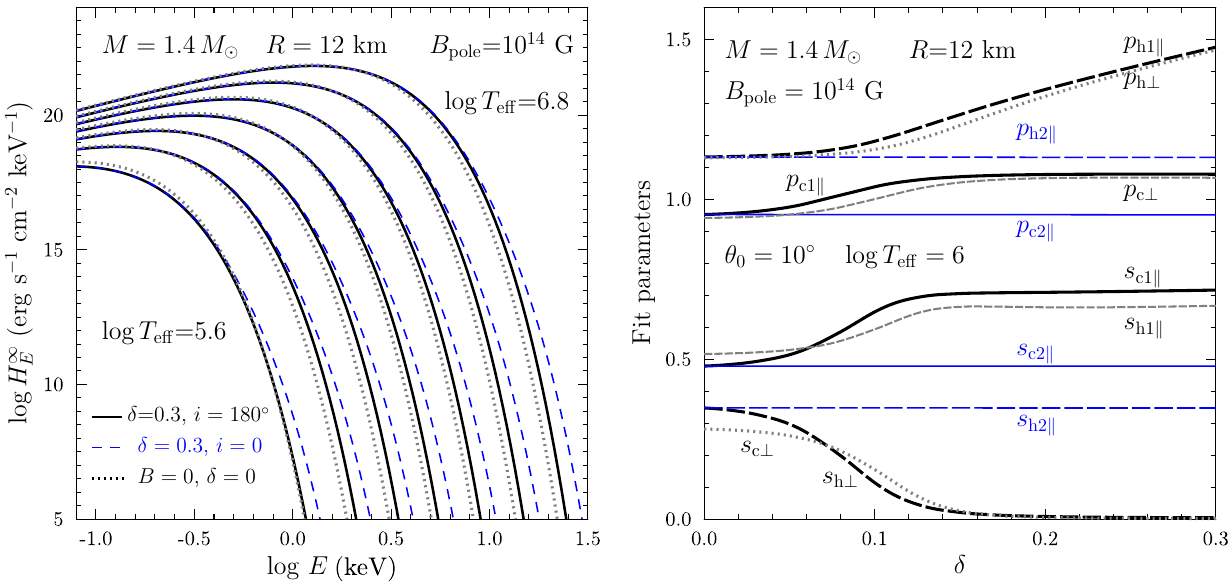
Figure 8. ( Left ): Theoretical spectral fluxes for a neutron star with M = 1.4 M and one extra hotspot on one magnetic pole at the extra heating parameter δ = 0.3. The solid and dashed curves are for non-heated ( i = 180 ◦ ) and heated pole ( i = 0) observations, respectively. ( Right ): Maps of fit parameters versus δ for this star at T eff = 1 MK. The thick solid and gray curves are for the north-pole and equator observations, respectively. Thin horizontal curves are for the south-pole